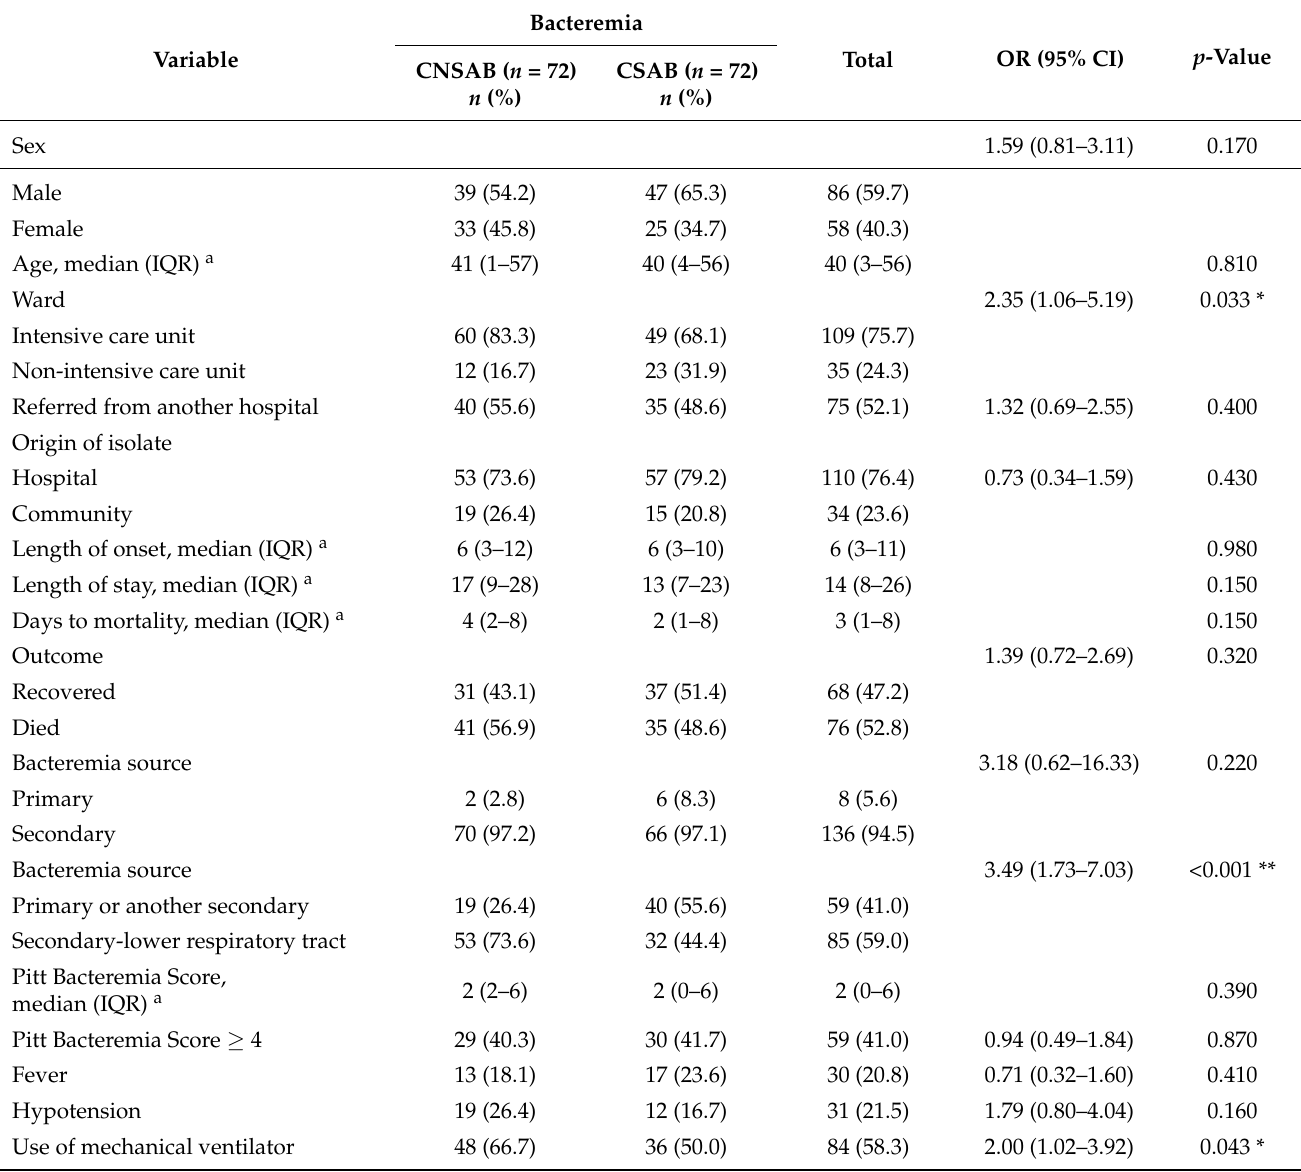
Table 1. Characteristics of respondents and potential risk factors for bacteremia due to CNSAB and CSAB ( n =